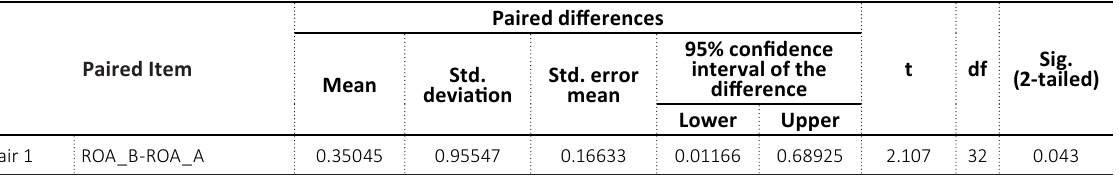
Table 3. ROA paired samples test